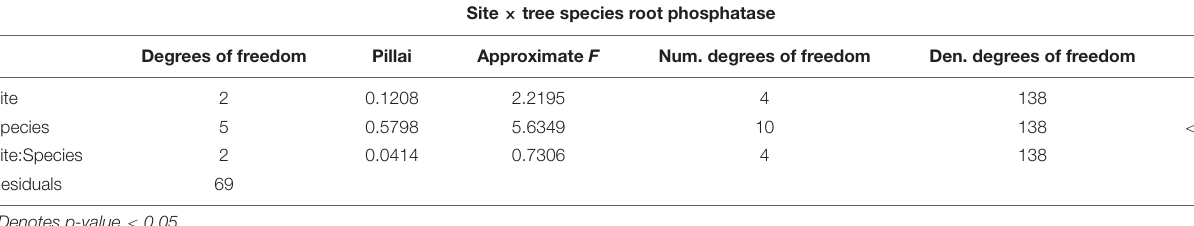
TABLE 2 | Site and tree species two-way repeated measures MANOVA of root PME and PDE activities.